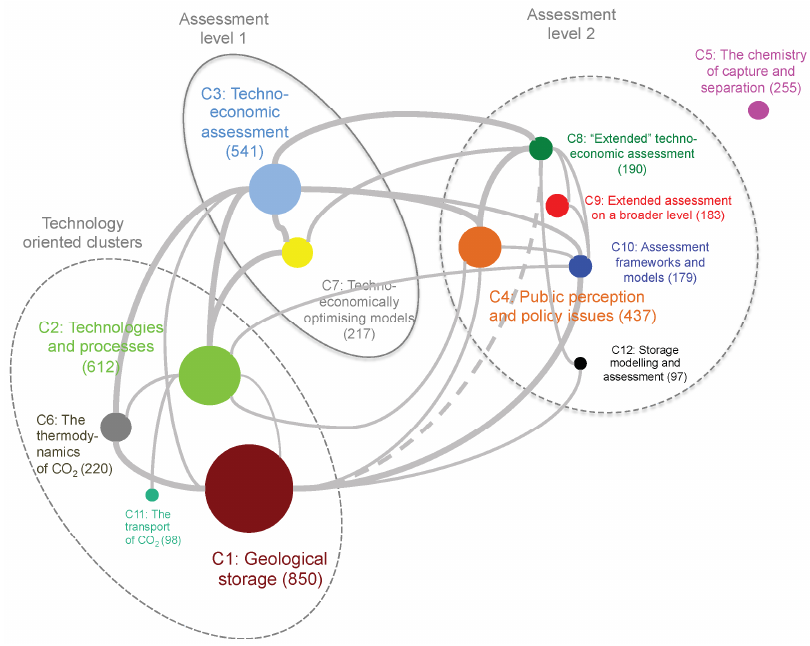
Figure 4. Main relationships between the central research clusters (the thicker the lines, the stronger the